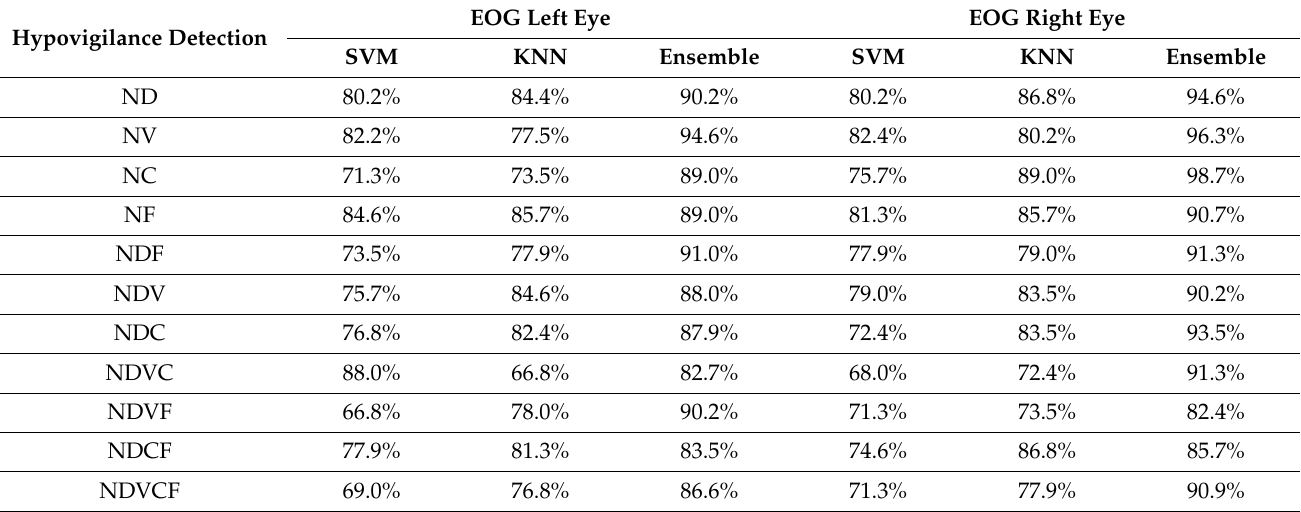
Table 3. Performance of EOG showed in hypovigilance state detection. Hypovigilance